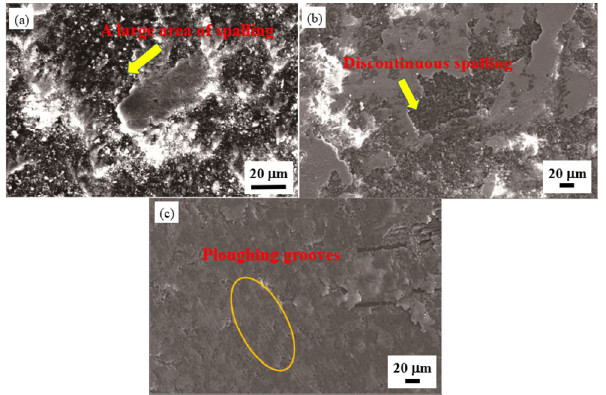
Fig. 9 Worn morphologies of 37%C f /LAS composites at different temperature: (a) 200 °C, (b) 300 °C, and (c) 400 °C.